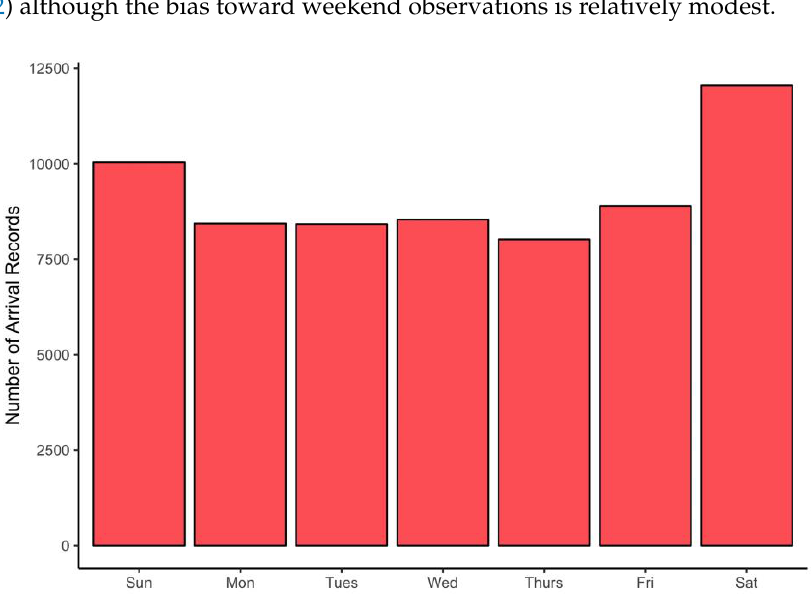
Figure 2. Frequency of observations by day of week.